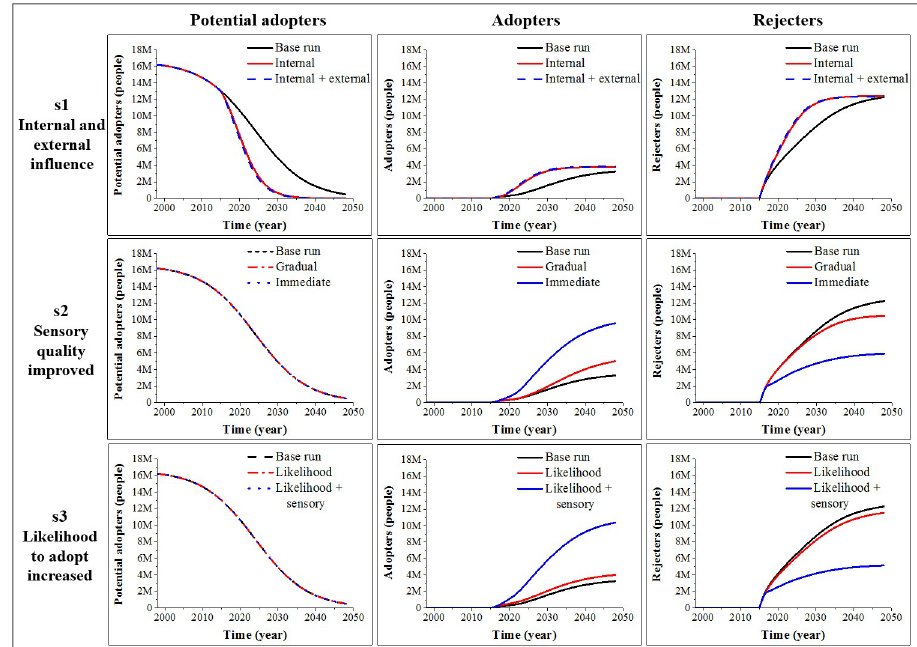
Fig 4. Behaviour of “Potential adopters”, “Adopters” and “Rejecters” stocks for 3 different scenarios (scenario 1 (s1): Increase in internal and external influence; scenario 2 (s2): Increase in sensory quality; scenario 3 (s3): Increase in likelihood to